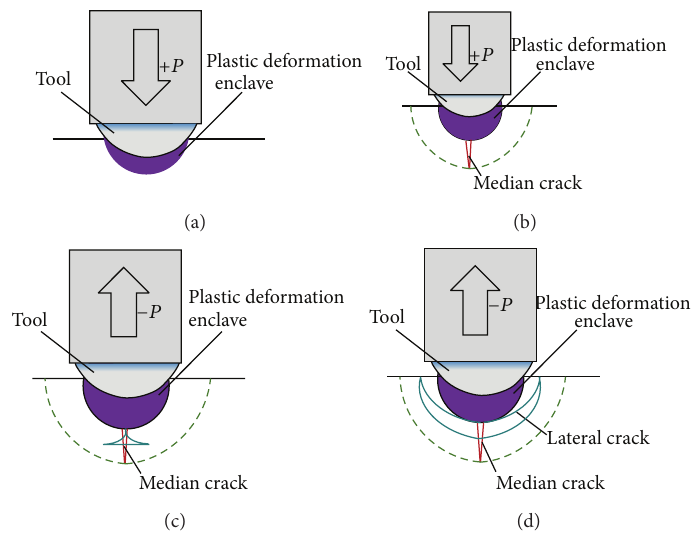
Figure 4: Indentation process of brittle